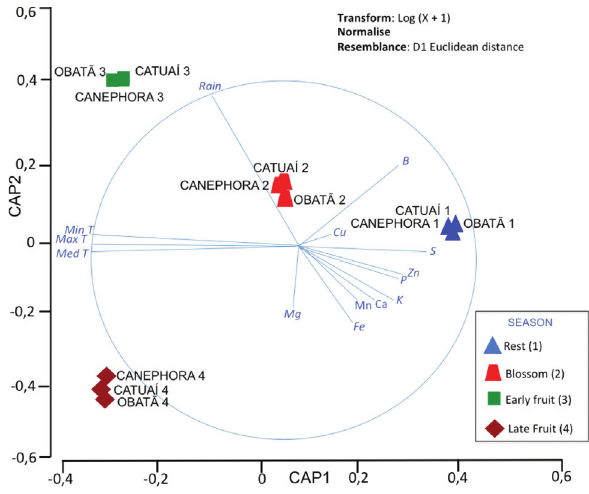
Figure 3 - Canonical analysis of principal coordinates (CAP) ordination betweentheenvironmentaldataandsamplecollectiontimes.Theenviron- mental data were overlaid as vectors to improve the visualization of corre- lations. Periods: ‘rest’ 1 - June 2013, ‘blossom’ 2 - September 2013, ‘early fruit’ 3 – January 2014, and ‘late fruit’ 4 – April 2014. T a